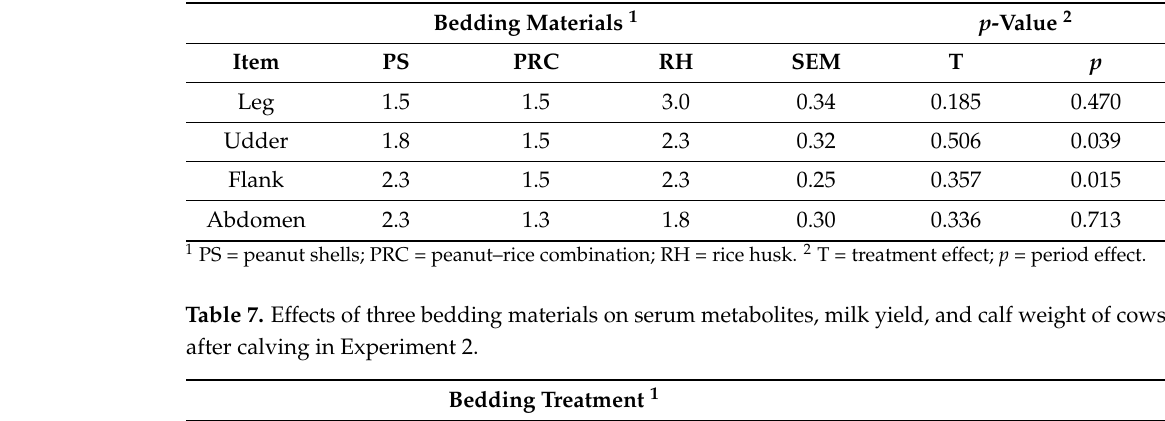
Table 6. Effects three bedding materials on the cleanliness scores of cows.